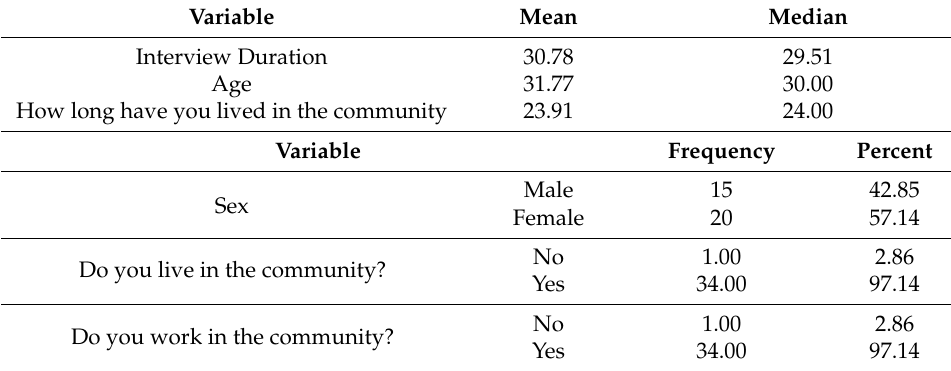
Table A1. Key respondents’ details, Participant, and Interview Descriptive